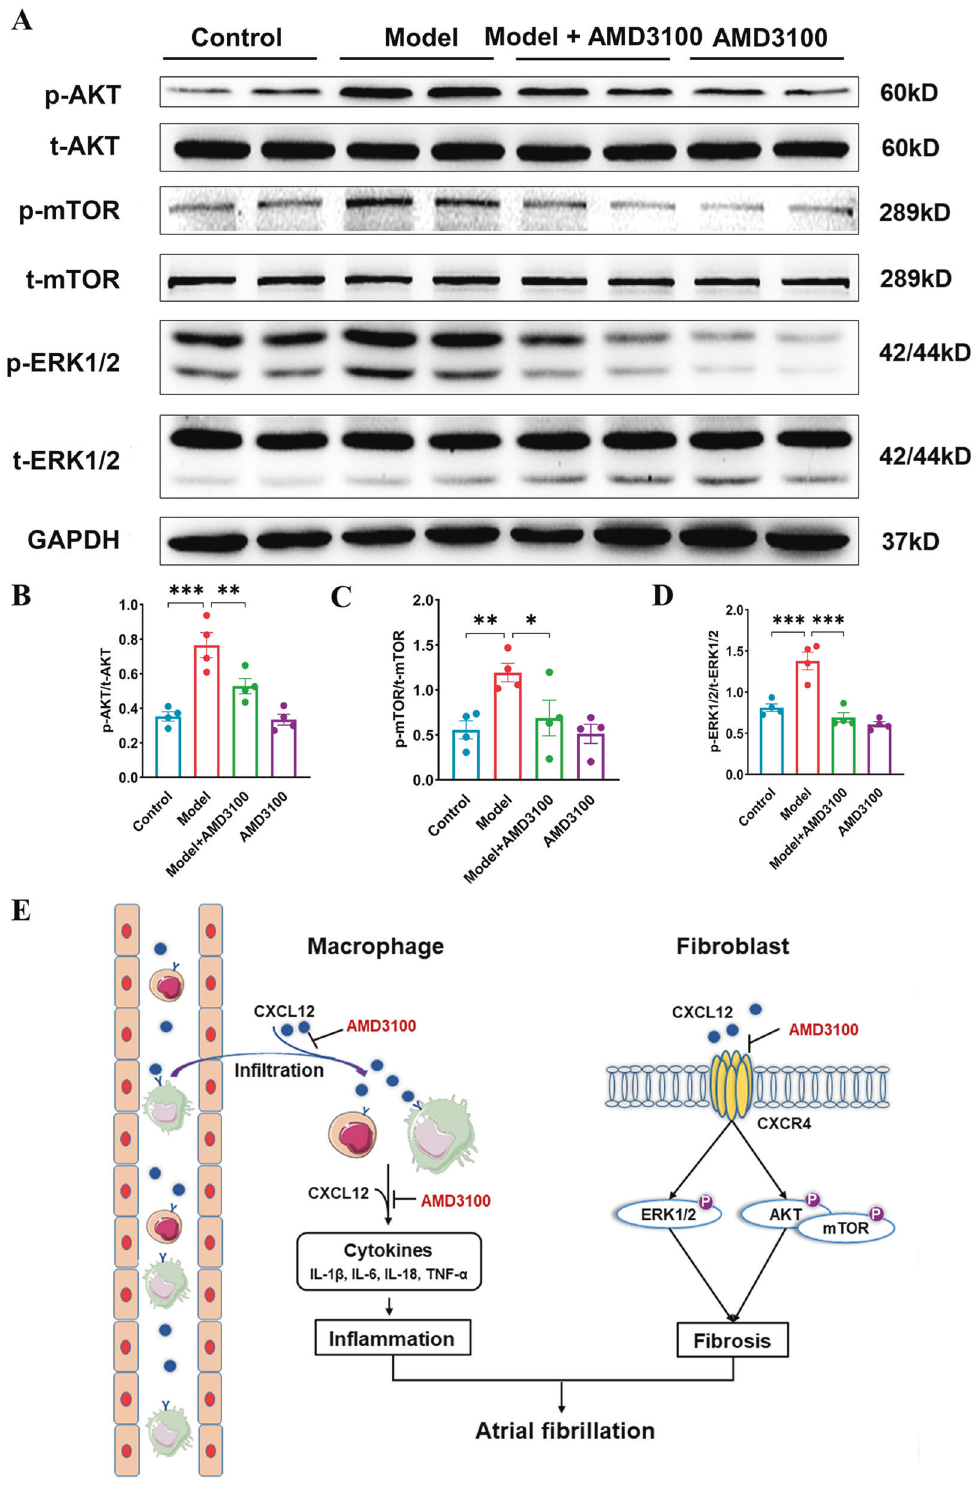
Fig. 6 AMD3100 treatment inhibits pro fi brotic signaling pathways in the atria of AF model mice. A Immunoblotting analysis of p-AKT, AKT, p-mTOR, mTOR, p-ERK1/2, and ERK1/2 protein levels in the atria. B – D Quanti fi cation of each protein band ( n = 4). GAPDH was used as an internal control. E A working model for CXCR4 mediated-AF development. AF upregulates CXCL12 expression to recruit CD3 + T lymphocytes and F4/80 + macrophages into the atrium, which trigger in fl ammation. Meanwhile, the upregulated CXCL12 and CXCR4 could directly activate the downstream pathways including ERK1/2 and AKT/mTOR, which induce atrial fi brosis. In contrast, pharmacological blockage of CXCR4 with AMD3100 blunted these effects. Results are expressed as the mean ± SEM, and n represents the number of animals in each group. ns P > 0.05, * P < 0.05, ** P < 0.01, *** P < 0.001.